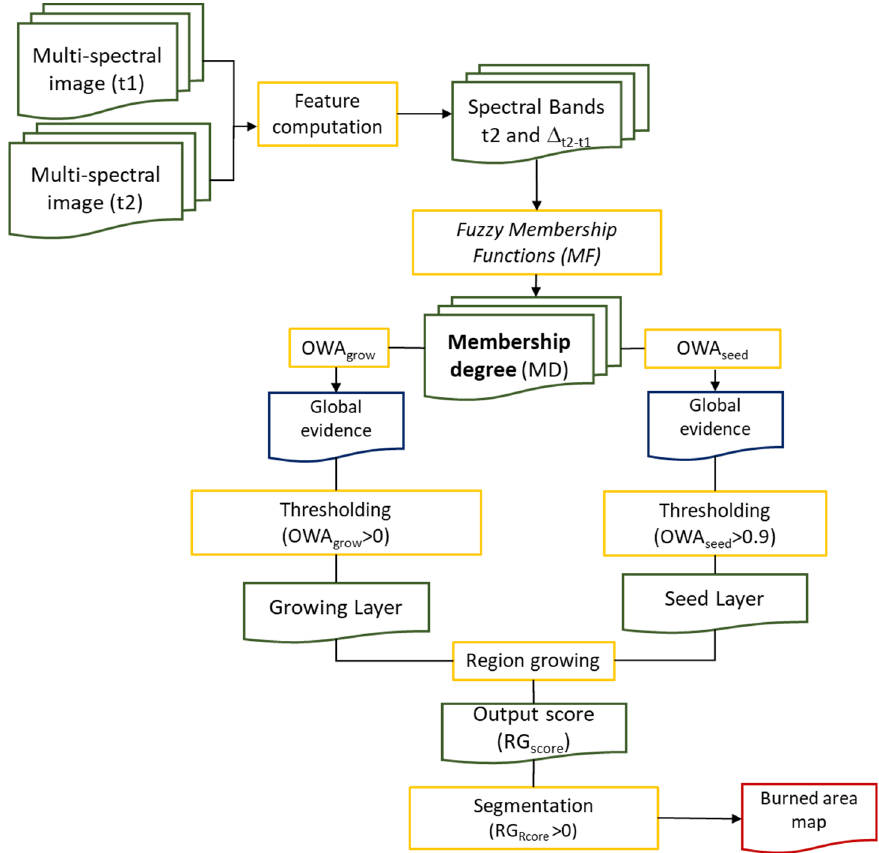
Figure 5. Flowchart of the processing steps from input S2 MSI images to generate BA maps.